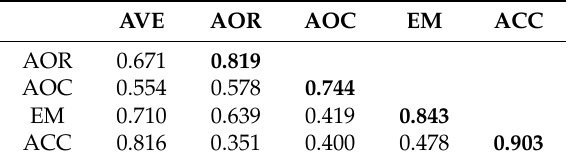
Table 8. Discriminant validity for the measurement